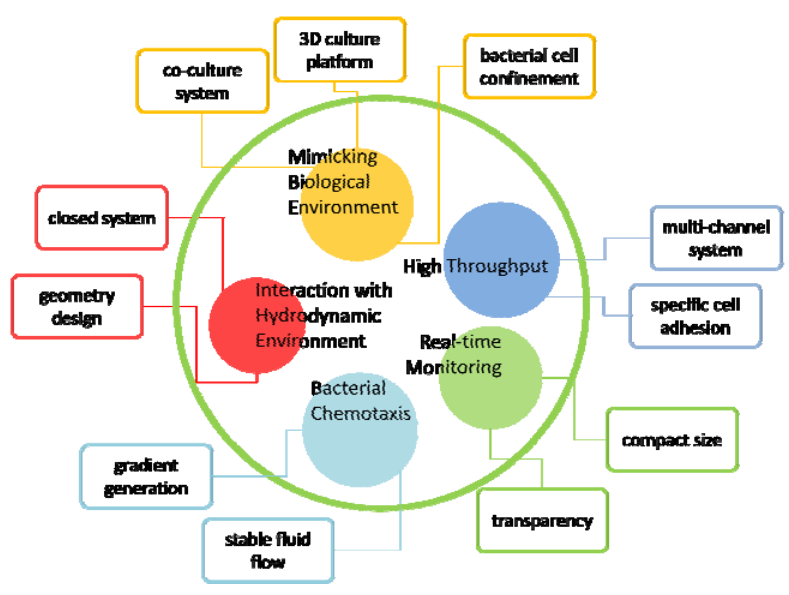
Figure 2. Advantages of microfluidics approach to bacterial biofilm studies. Microfluidics and micro-fabricated platforms have various characteristics as shown in the box that